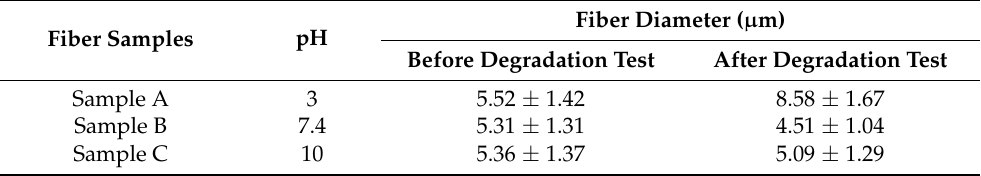
Figure 9. ( a – c ) SEM images of the degraded PCL/PLA/TBC fibers at pH values of 3, 7.4 and 10 re- spectively. ( d – f ) SEM images of the degraded single fiber at pH values of 3, 7.4 and 10 respectively. Table 3. Changes in average fiber diameter at different pH